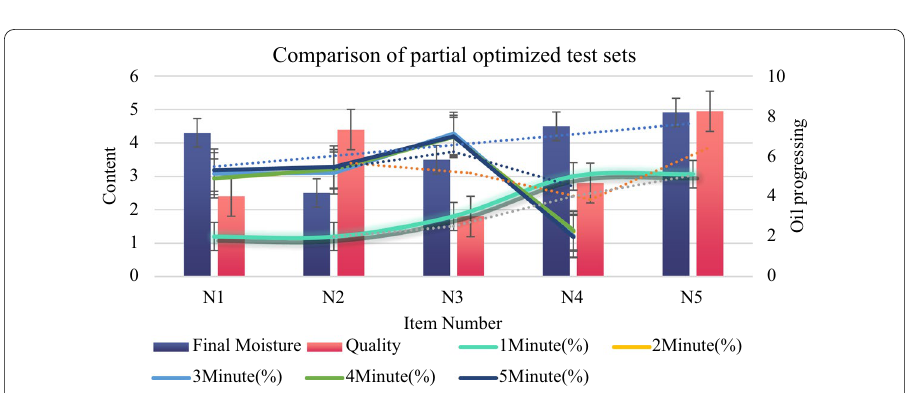
Fig. 12 Comparison of partial optimized test